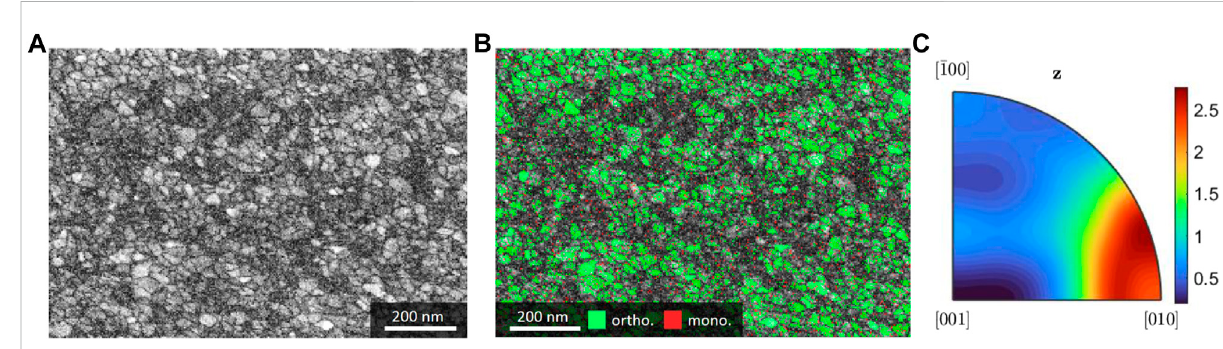
FIGURE 3 TKD analysis of a HZO/Al 2 O 3 heterostructure. The grain structure can be observed in the quality map (A) , which visualized the measured band contrast.Phaseextraction (B) indicatespredominantorthorhombicphase.Crystallographicorientationissummarizedbytheinversepole fi gure(IPF) in out-of-plane (z) direction (C) , indicating a pronounced texture of the [010]-axes aligning